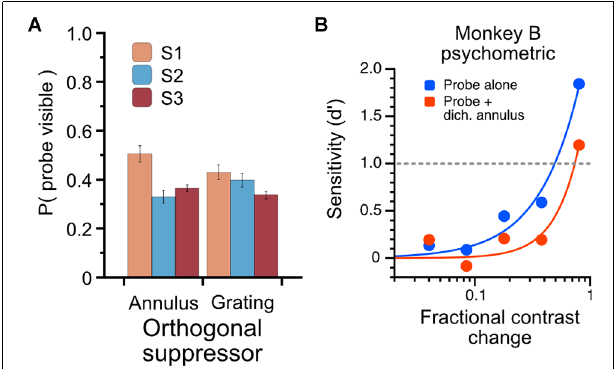
FIGURE 8 | Characterization of psychophysical suppression elicited by dichoptic probe-annulus pairs. Three human subjects each viewed the modulating probe grating and dichoptic suppressor for a total of six full runs through the noise sequence; subjects indicated with a button press when the probe was visible. (A) The total proportion of stimulus duration in which probes were dominant. Dichoptic annuli and dichoptic gratings drove similar perceptual suppression for subjects (mean proportion of probe visibility: annulus suppressor, 0.4 ± 0.09; grating suppressor, 0.39 ± 0.05). (B) Psychophysical influence of dichoptic annulus on contrast sensitivity in Monkey B. Contrast change-detection performance was measured using a 2-alternative forced-choice task for probe-alone condition (blue) and probe plus dichoptic annulus (red). Contrast sensitivity was substantially lower when a thin annulus was presented to the non-dominant eye simultaneously with the probe